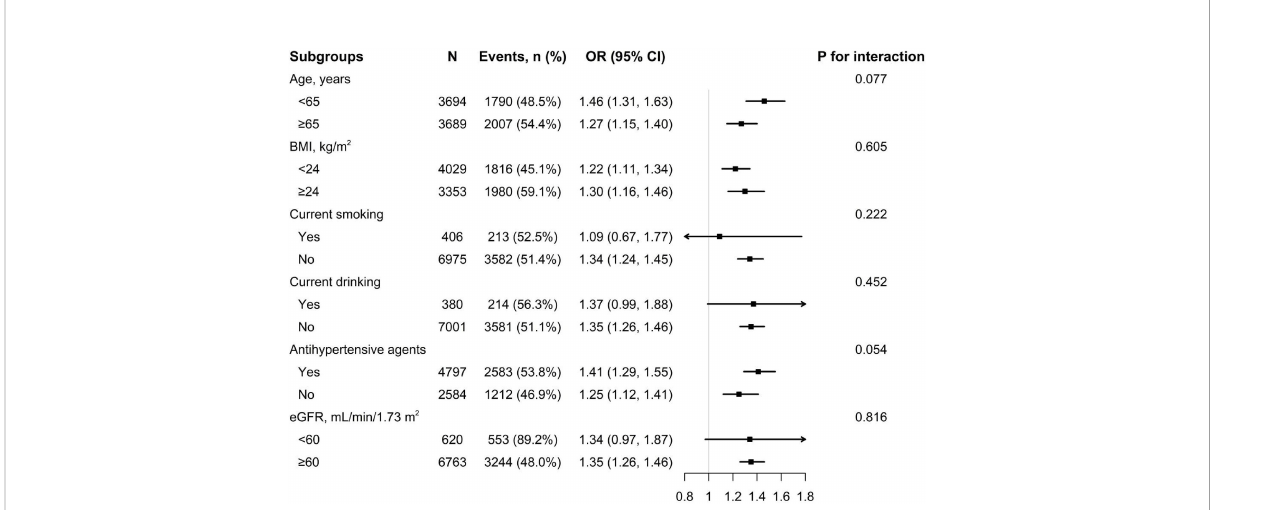
FIGURE 3 Subgroup analysis of the association between WWI and hyperuricemia among women. Each subgroup analysis is adjusted if not strati fi ed for age, heart rate, stroke, diabetes mellitus, coronary heart disease, current smoking, current drinking, antihypertensive drugs, lipid-lowering drugs, glucose-lowering drugs, homocysteine, serum total cholesterol, triglyceride, high density lipoprotein, low density lipoprotein, and